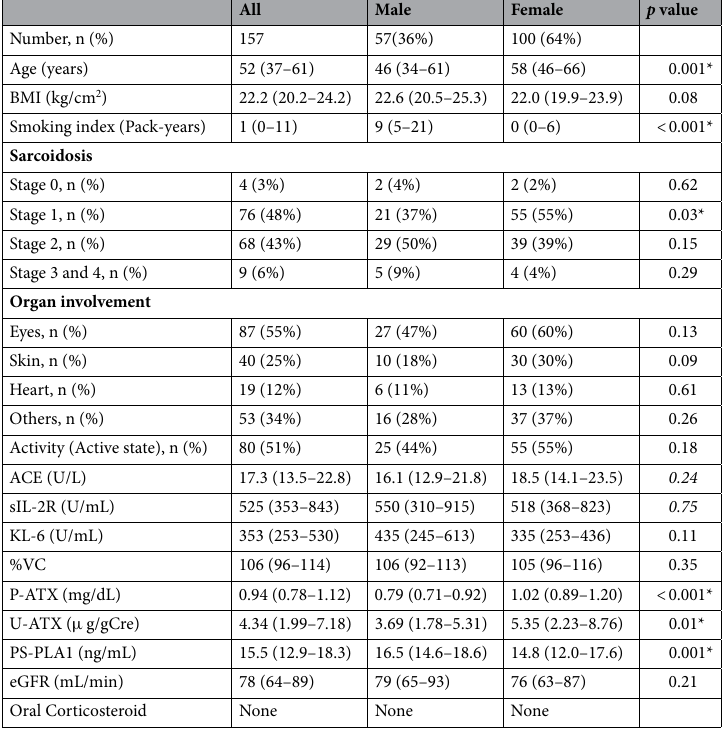
Table 1. Characteristics of patients with sarcoidosis. Data are expressed as median and interquartile range (IQR, Q1-Q3). The clinical characteristics were compared using Mann–Whitney U-test or Fisher’s exact test. Statistical significance was accepted as p < 0.05 and marked by an